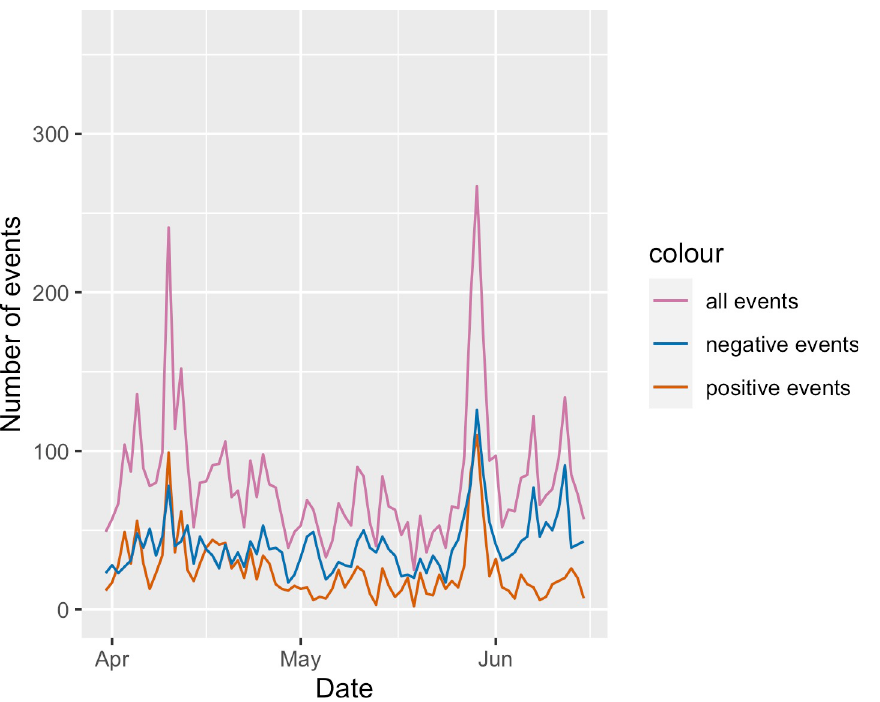
Fig 4. Raw event count time series for target filtered data.